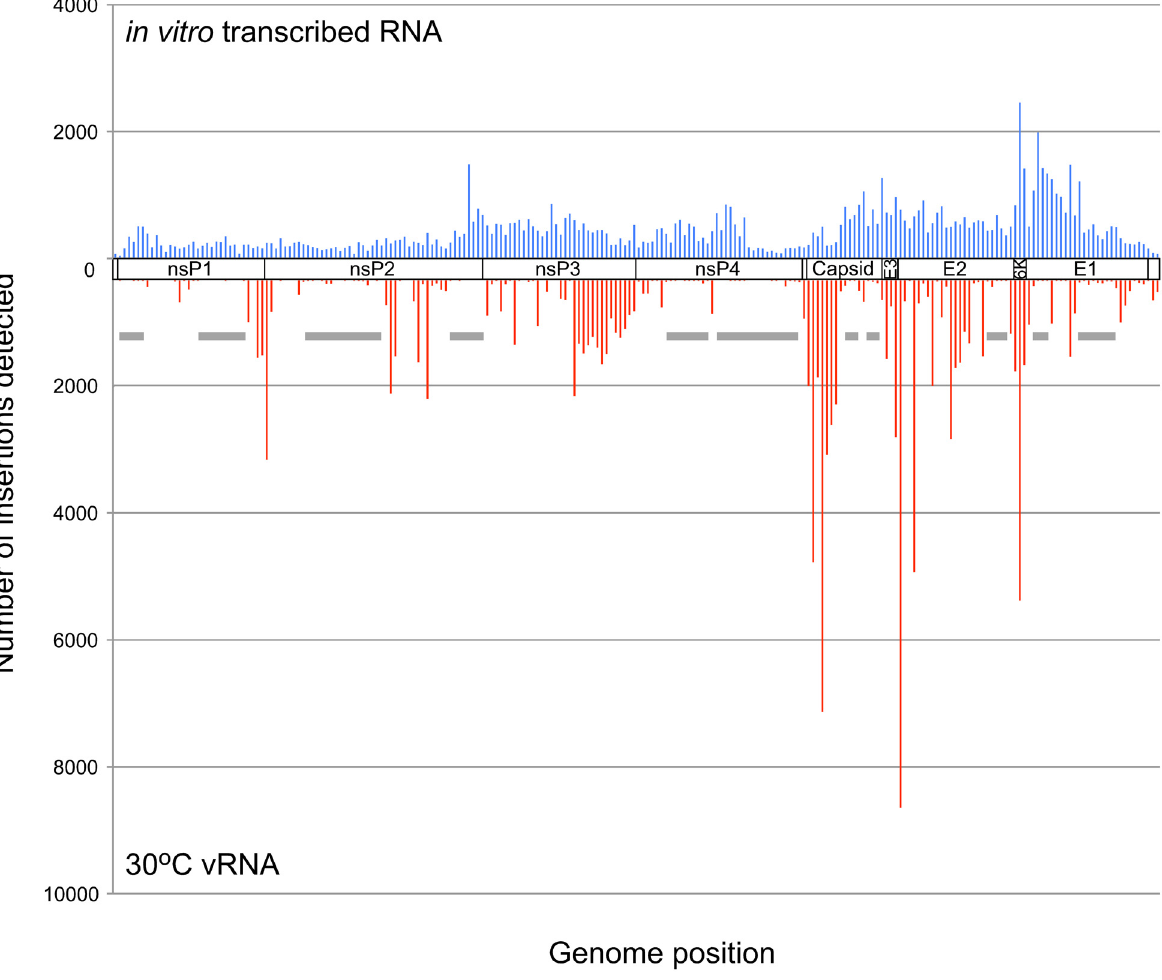
Figure 3. Frequency of insertion sites found in unselected RNA versus vRNA from virus produced at 30 u C. The frequency of transposon insertions at each nucleotide position in the VEEV genome was calculated from the GS-FLX sequencing data and normalized to account for differences in the total number of sequencing reads obtained from each sample. For this histogram, the VEEV genome was divided into bins of 50 nucleotides from 5 9 to 3 9 , and the total number of insertions in each bin was calculated. Insertion frequencies in unselected RNA are shown on top in blue, and vRNA isolated from virus produced at 30 u C is shown in red. The approximate location in the genome is indicated between the two datasets. Gray bars indicate some of the regions intolerant to insertions at 30 u C.